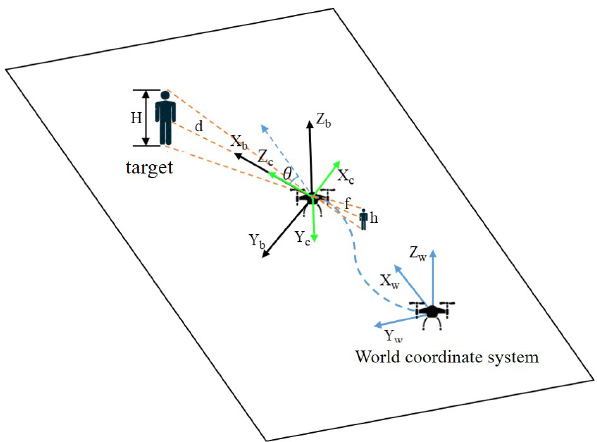
Figure 7. Schematic diagram of coordinate